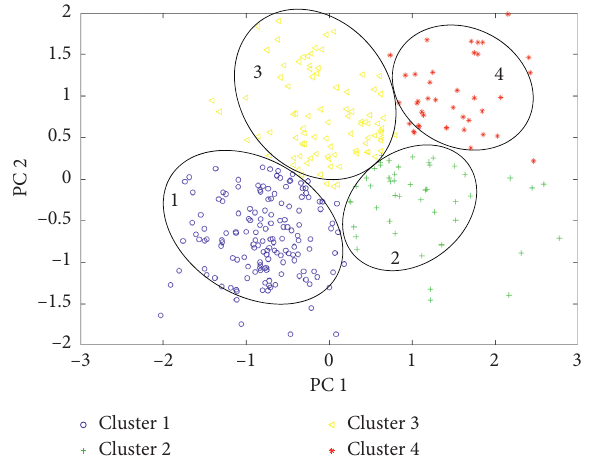
Figure 11: Stations clustering renderings.